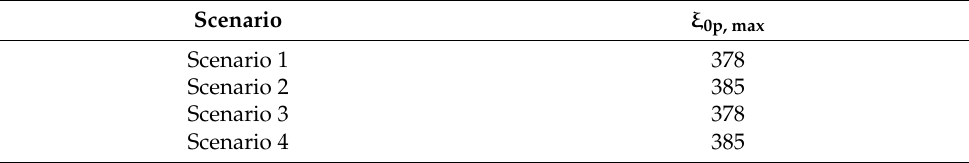
Table 7. Number of cases valid for the formula validity parameters 2.